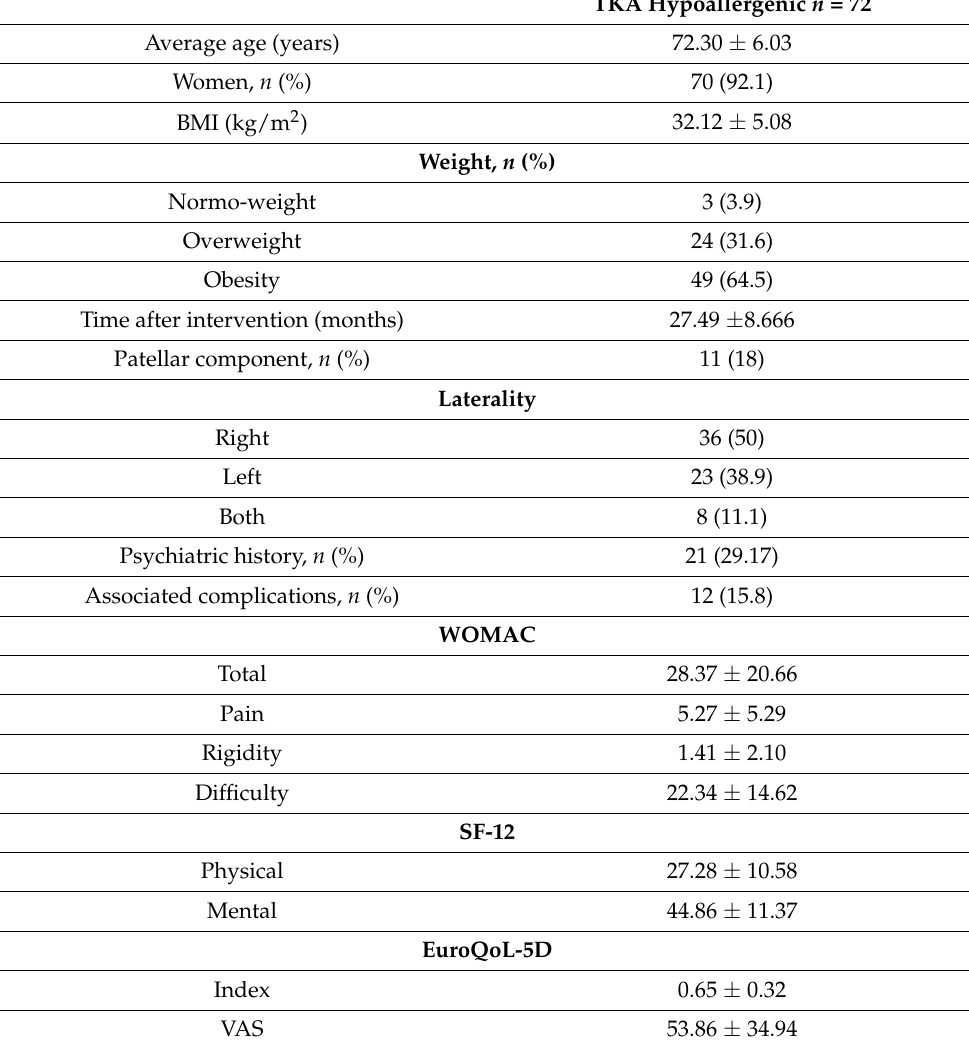
Table 2. Descriptive characteristics of the study sample. The results are presented as the mean ± standard deviation (SD) or total value and percentage. Body Mass Index (BMI), Western Ontario naire), The EQ-5D-5L questionnaire essentially consists of 2 pages: the EQ-5D descriptive system (Euro-Qol-5D) and Visual Analog Scale